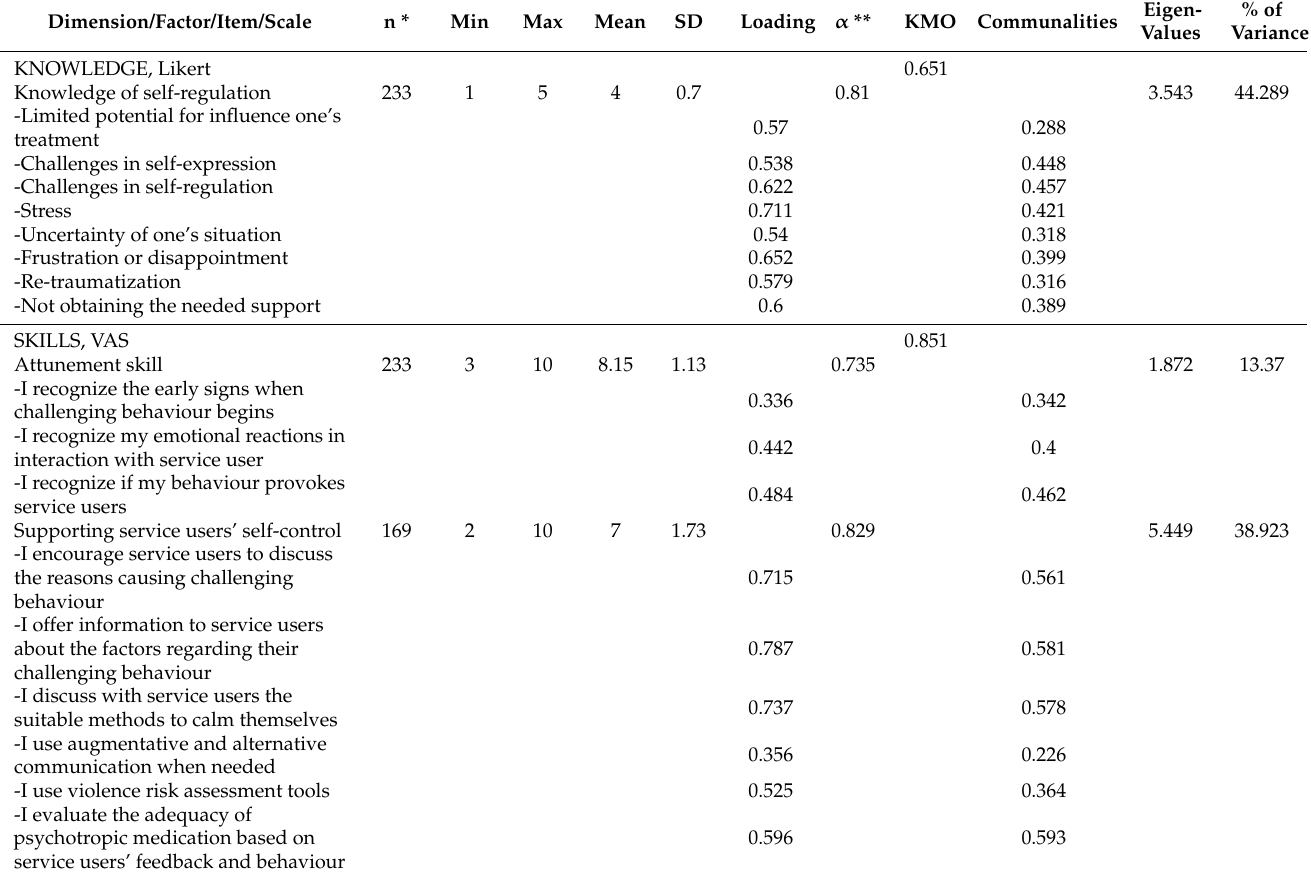
Table 3. Structure, content, and psychometric properties of validated HCMCB